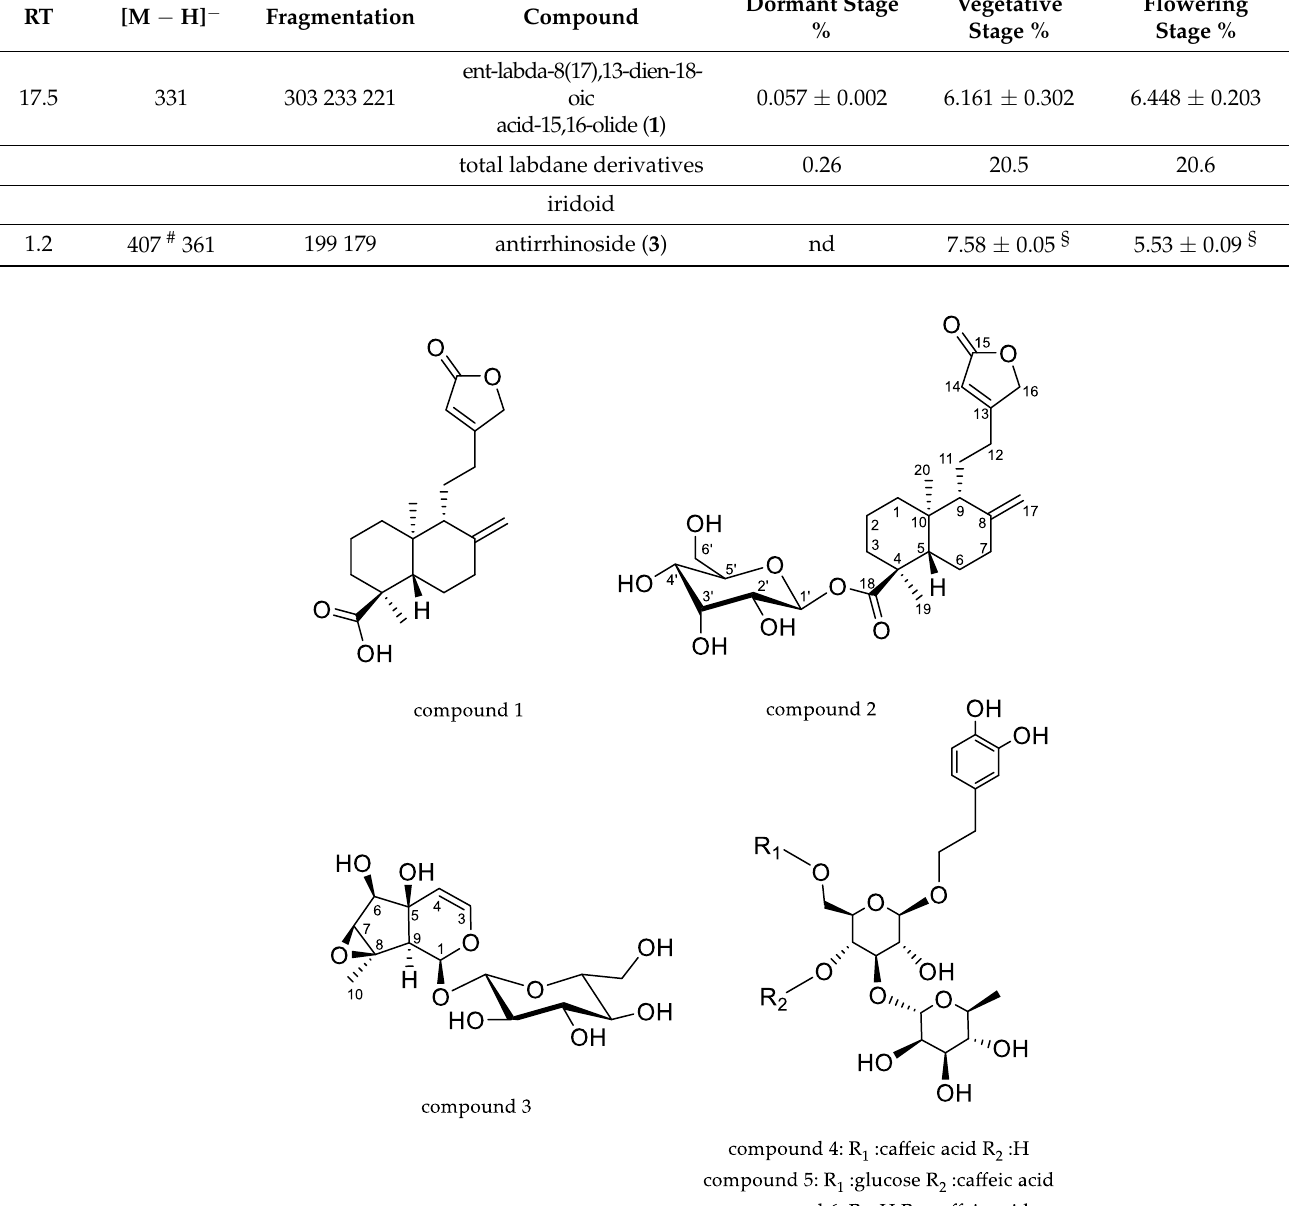
Figure 3. Chemical structures of compounds isolated from R. michauxii extract. Compound 1: ent- labda-8(17),13-dien-18-oic acid-15,16-olide; compound 2 : ent-labda-8(17),13-dien-18-glucopyranosyl ester-15,16-olide; compound 3: antirrhinoside, compound 4: isoverbascoside; compound 5: echinacoside; compound 6: verbascoside.